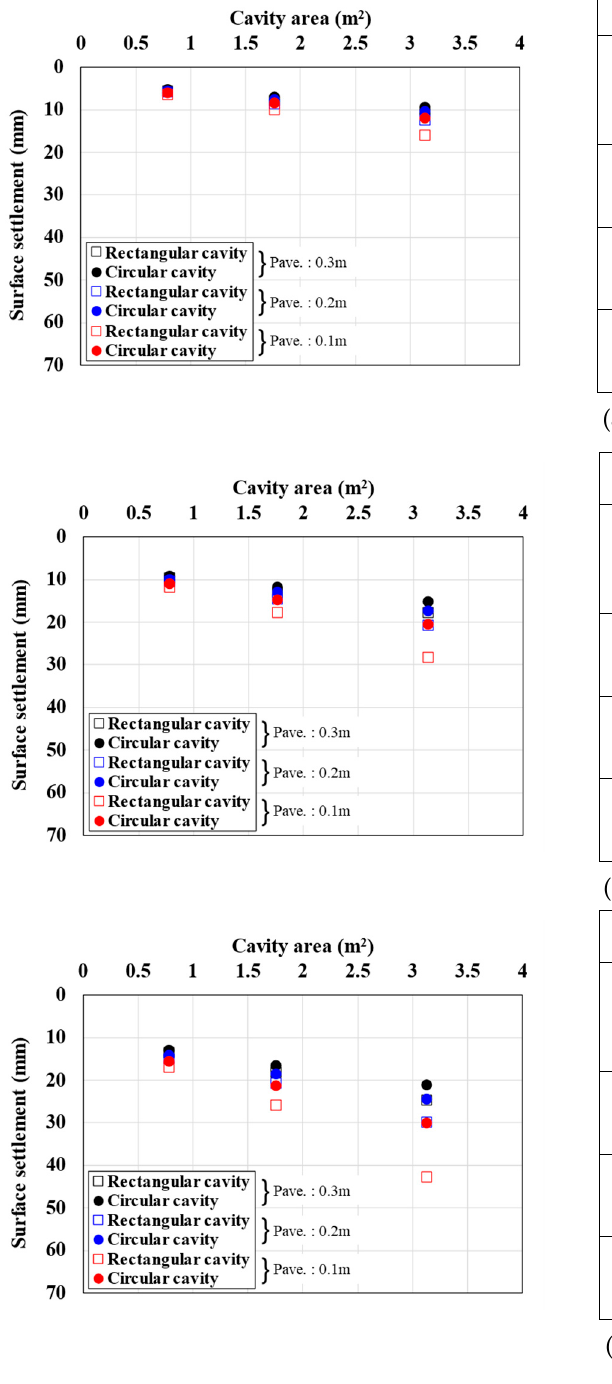
Figure 7. Surface settlement according to cavity area by pavement thickness (pavement elastic modulus: 3000 MPa). Traffic load: ( a ) 12.7, ( b ) 25.4, and ( c ) 38.1 kN/m 2 .